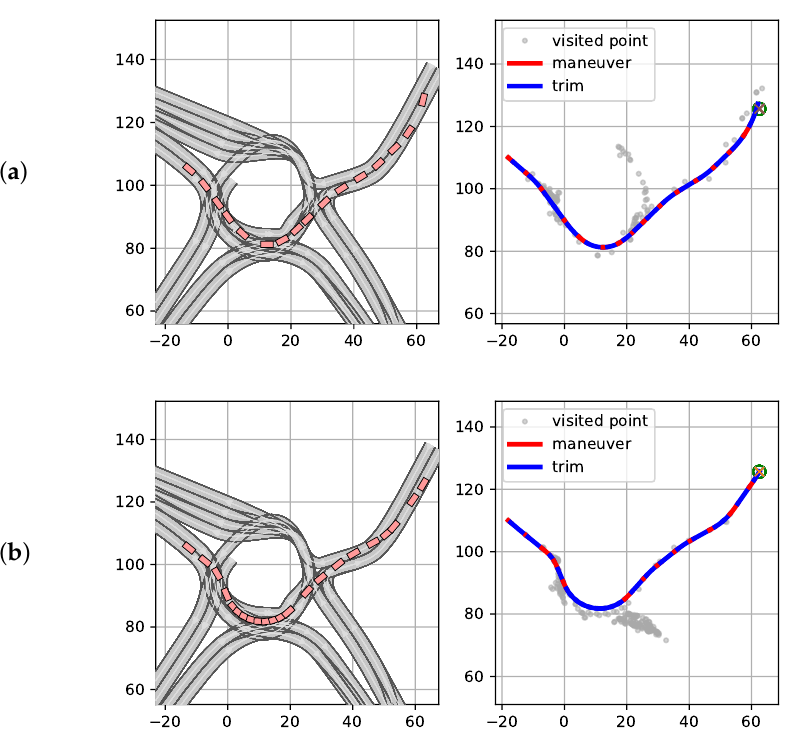
Figure 17. Trajectories for the automaton with 43 trims: ( a ) handcrafted; ( b )